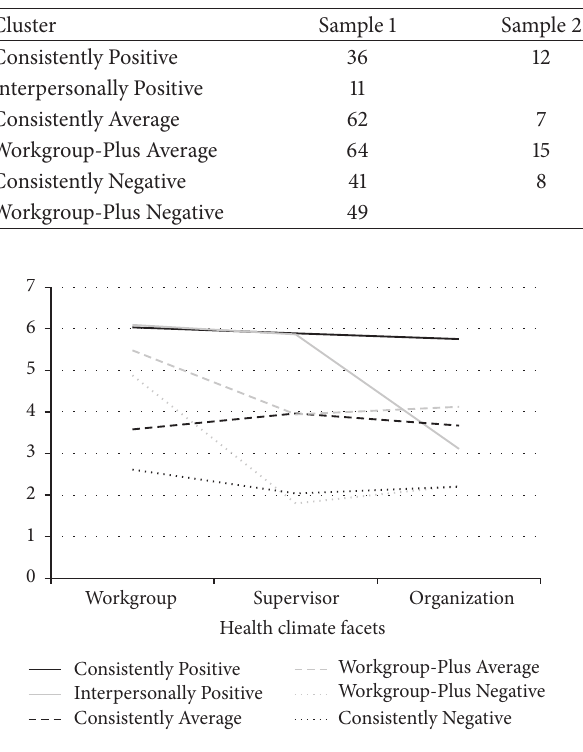
Figure 1: Sample 1 𝑘 -means cluster solution.